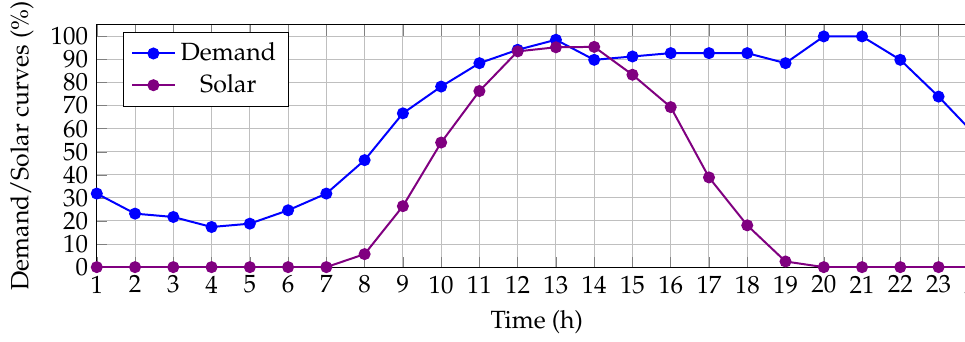
Figure 3. Daily demand and generation curves for Medellín, Colombia.